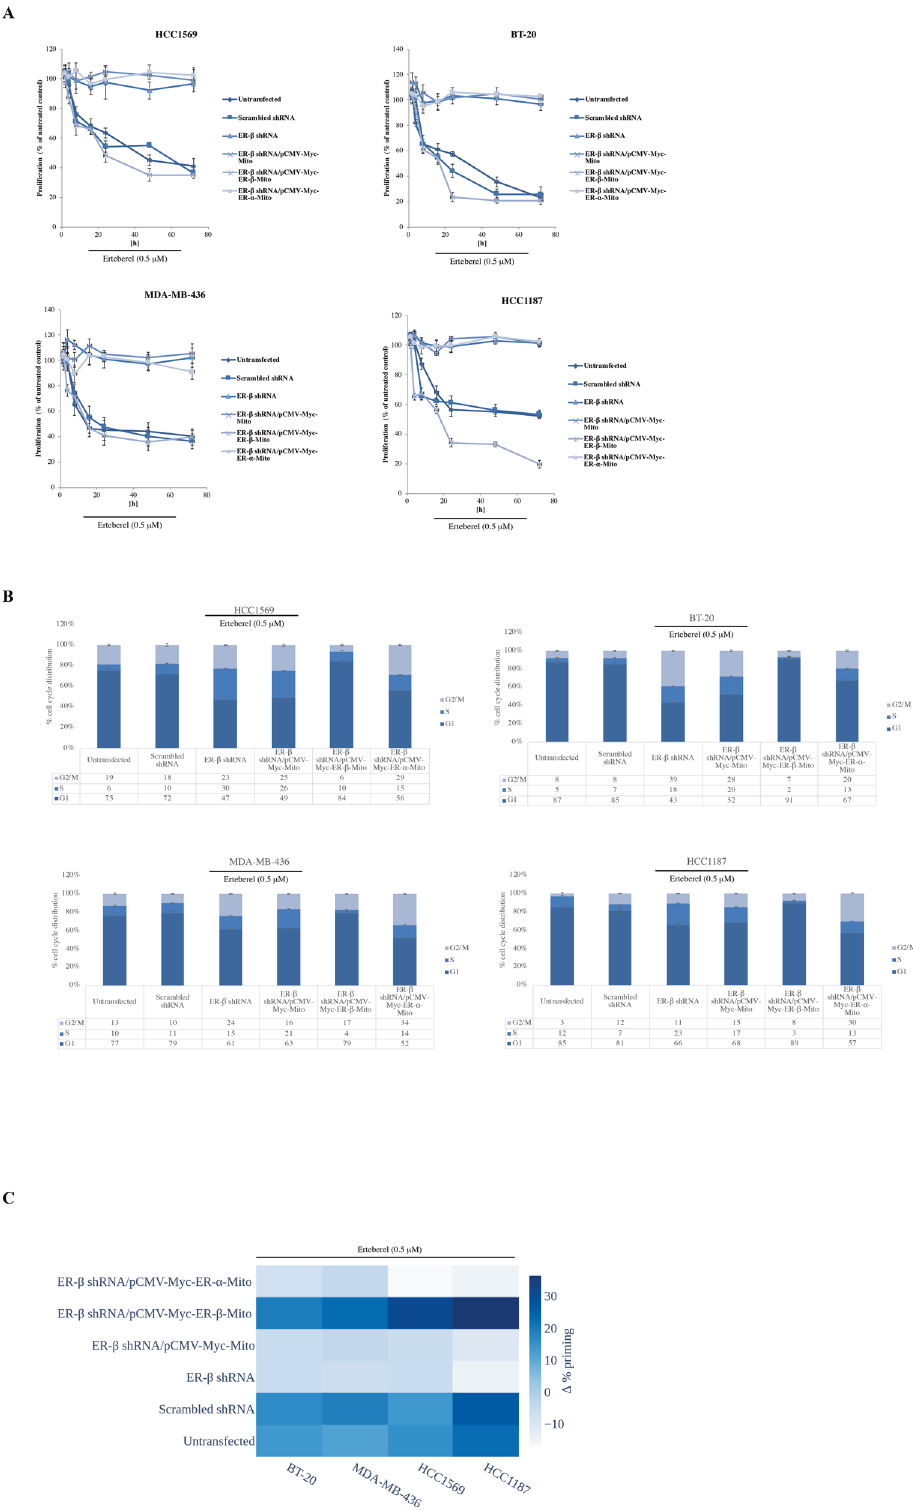
ER- β shRNA, which was restored by enforced expression of mitochondria-targeted ER- β , but not by mitochondria-targeted ER- α (Fig. 7C). Taken together, our results supported the role of mitochondrial ER- β as a target for selective ER- β agonists in breast cancer cells lacking ER- α